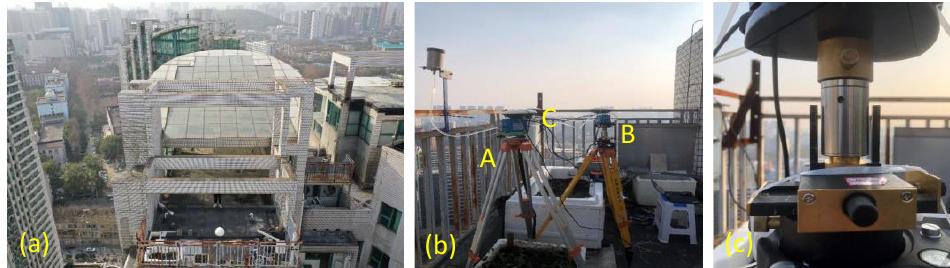
Figure 6. ( a ) Observing environment; ( b ) site settings; ( c ) height adjustment device.